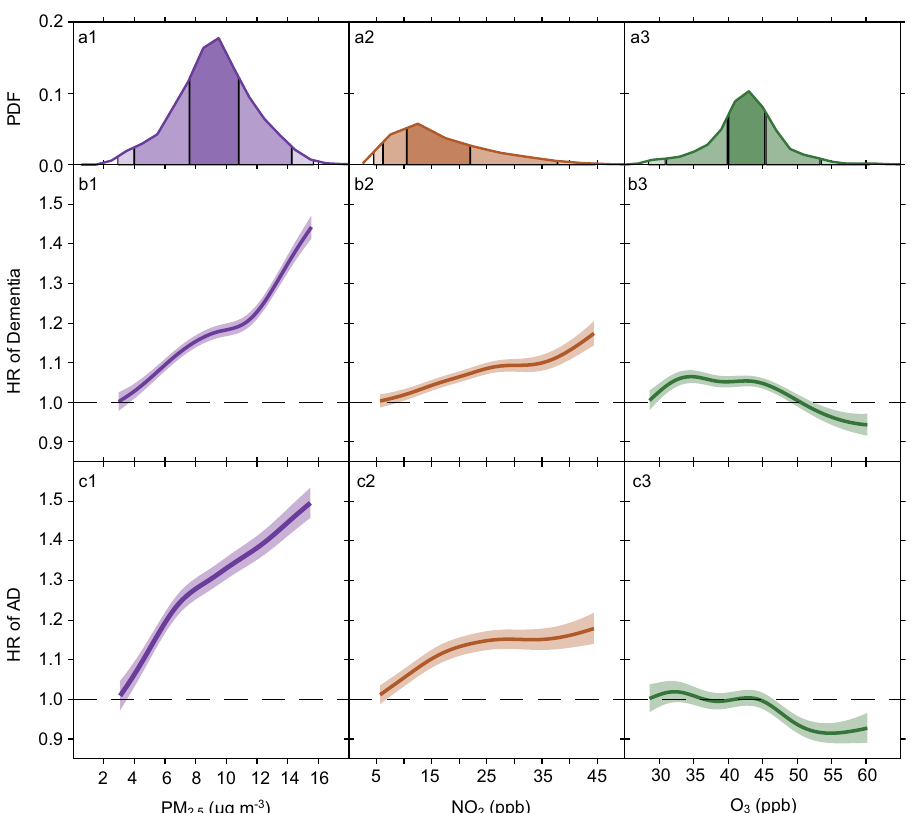
Fig. 3 Concentration-response curves. Panel. a presents the probability distribution functions (PDF) of long-term PM 2.5 , NO 2 , and O 3 exposures; Panel b presents the concentration – response relationships between each pollutant and dementia; Panel c presents the concentration-response relationships between each pollutant and Alzheimer ’ s disease (AD). The concentration – response curves, derived from the tri-pollutant models, are shown for the concentration ranges between 0.5th to 99.5th percentiles of the pollutants, i.e. with 1% poorly constrained extreme values excluded. Shading areas (from the darkest to the lightest) in a represent pollutant concentration ranges of the IQR (i.e., 25th to 75th percentiles), 95% (2.5th to 97.5th), and 99% (0.5th to 99.5th), respectively. Source data are provided as a Source Data fi